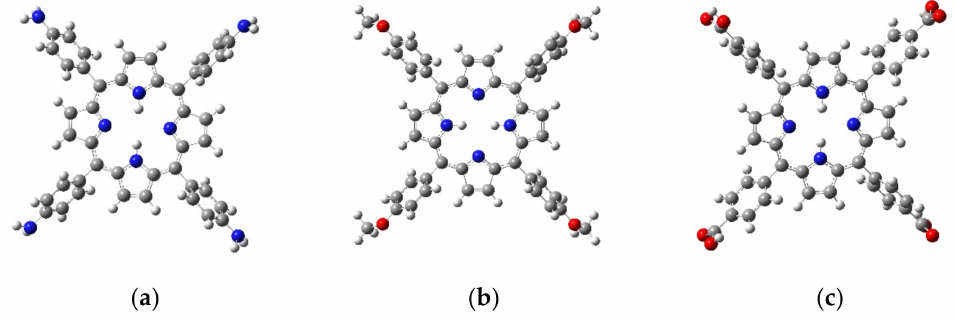
Figure 8. The chemical structure of the studied porphyrins: ( a ) TAPP, ( b ) TMPP, ( c ) TCPP (blue—N atoms, red—O atoms, grey—C atoms, white—H